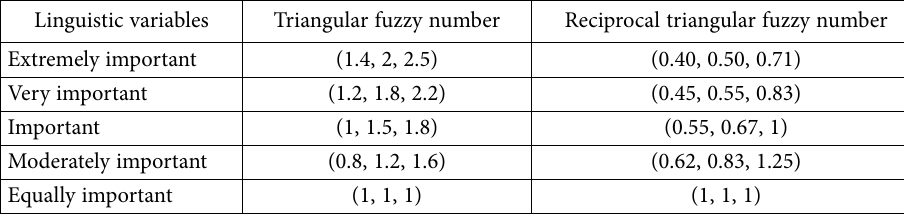
Table 1. Linguistic variables expressed by triangular fuzzy numbers Linguistic variables Triangular fuzzy number Reciprocal triangular fuzzy